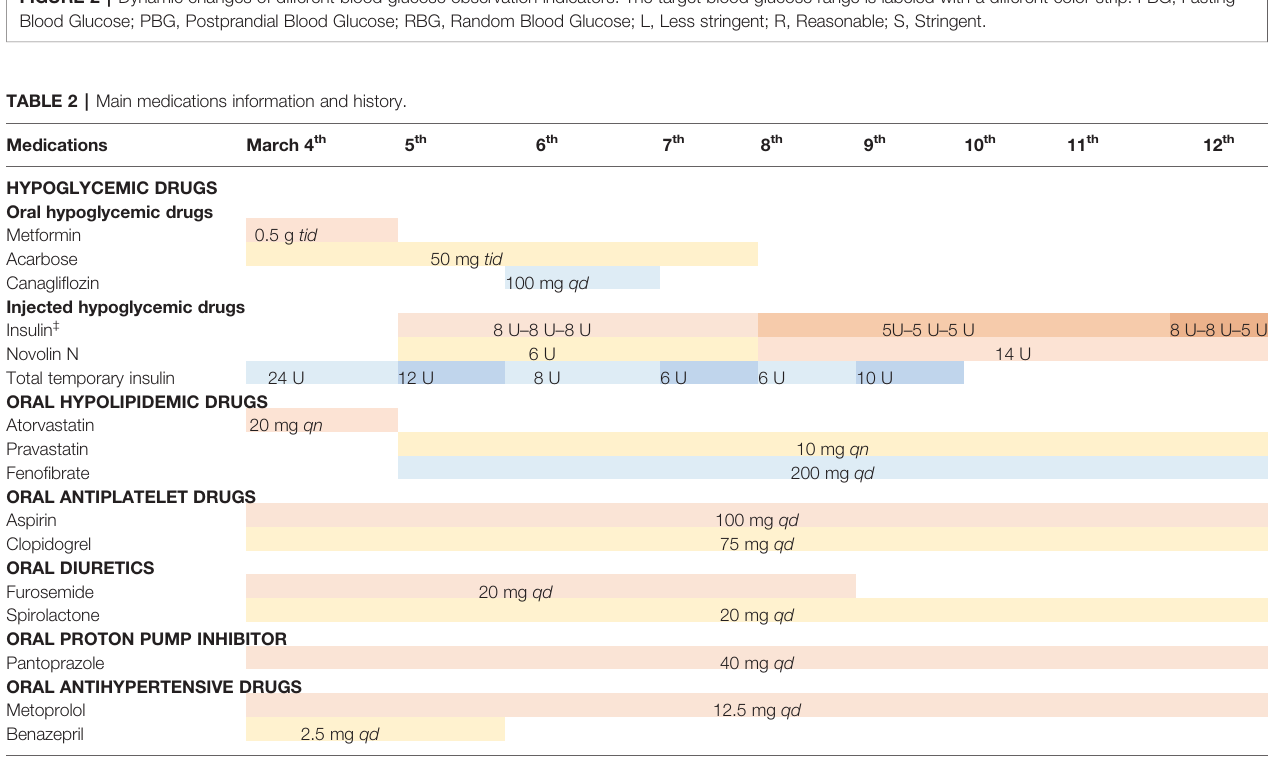
FIGURE 2 | Dynamic changes of different blood glucose observation indicators. The target blood glucose range is labeled with a different color strip. FBG, Fasting Blood Glucose; PBG, Postprandial Blood Glucose; RBG, Random Blood Glucose; L, Less stringent; R, Reasonable; S,